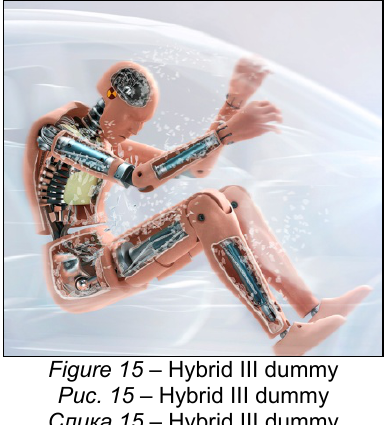
Figure 15 – Hybrid III dummy Рис . 15 – Hybrid III dummy Слика 15 – Hybrid III